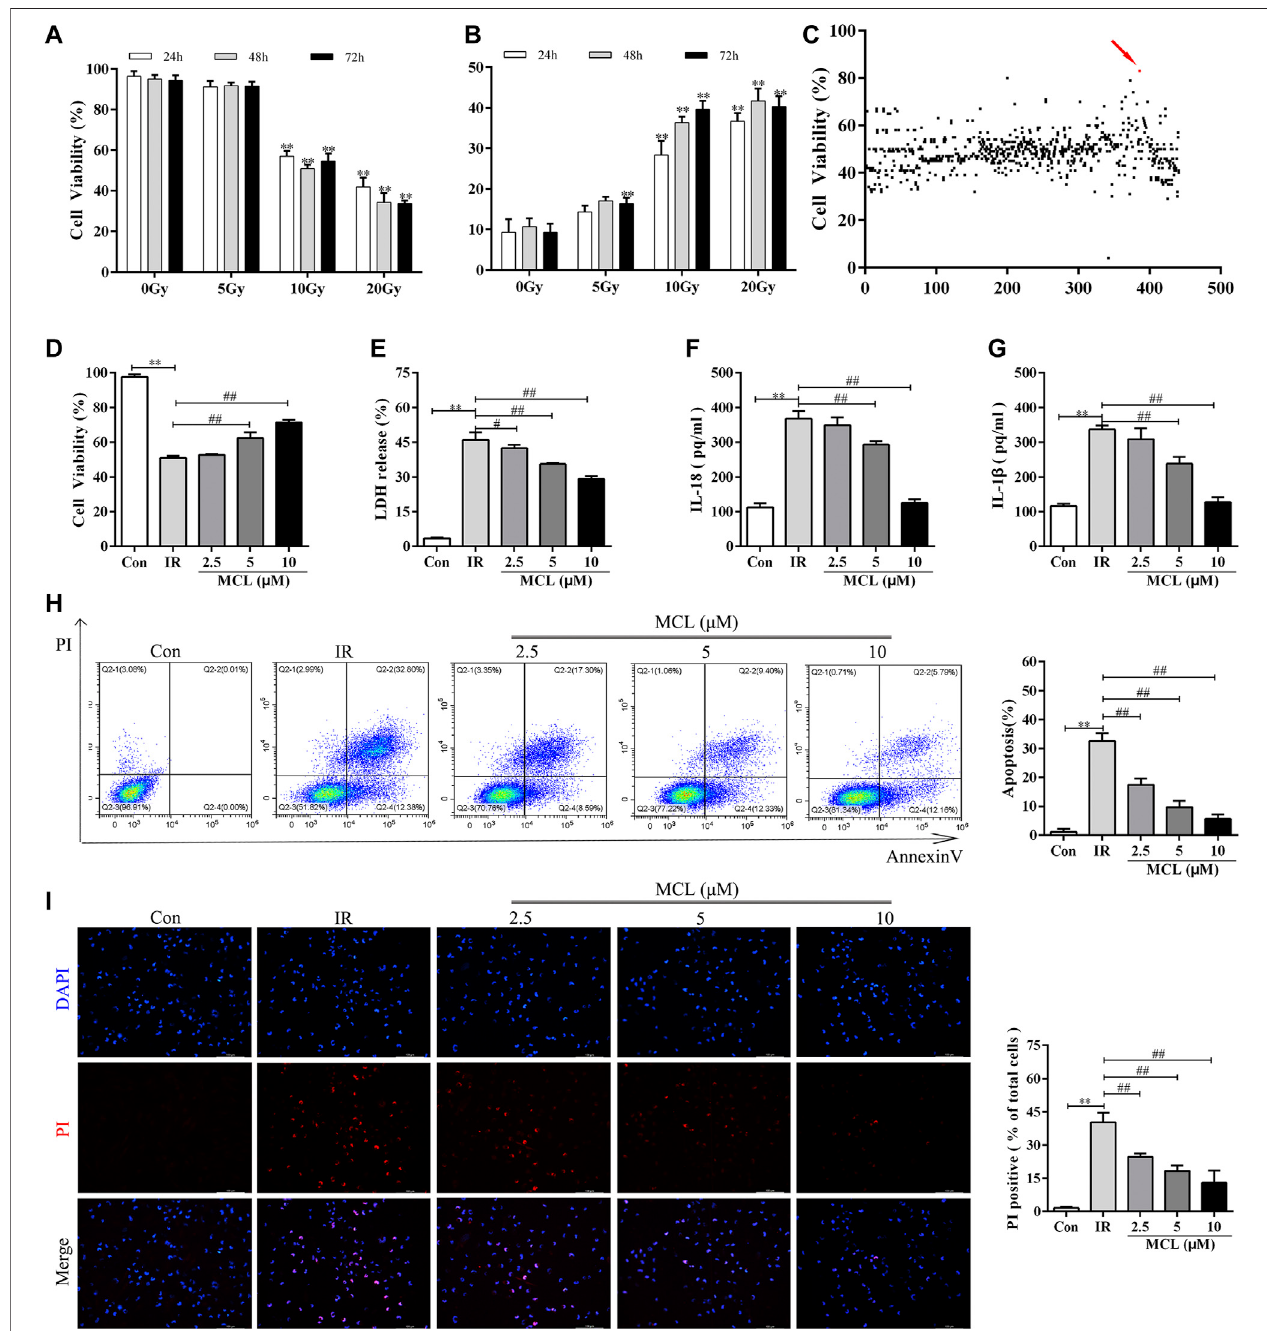
FIGURE1| MCLprotectsagainstradiationinHIECs (A) Cellviabilitywassigni fi cantlydecreasedinadose-dependentmannerfollowingtreatmentwithradiation(0, 5, 10, or 20 Gy) for 24, 48, or 72 h (B) LDH release increased in a time-and dose-dependent manner following radiation (0, 5, 10, or 20 Gy) (C) Cells were treated with 10 μ M ofthe drugcandidatelibrary for2 hand then exposed toradiation (10 Gy).Cell viabilityofHIECs exposedtothe drugcandidate library. Each point representsthe percentage ofcell viability ofthe compounds at aconcentration of10 μ M (D) MCL increased cell viabilityfollowing radiation (10 Gy)in adose-dependent (0, 2.5, 5, or 10 μ M) manner (E) MCL decreased LDH release following radiation (10 Gy) in a dose-dependent (0, 2.5, 5, or 10 μ M) manner (F) MCL decreased cell culture supernatant IL-18 release following radiation (10 Gy) in a dose-dependent (0, 2.5, 5, or 10 μ M) manner (G) MCL decreased cell culture supernatant IL-1 β release followingradiation (10 Gy) inadose-dependent (0, 2.5, 5, or10 μ M) manner (H) HIECs were pretreated with different concentrations(0, 2.5, 5, or10 μ M) ofMCL for 2 h and exposed to 10 Gy radiation. Representative fl ow cytometry scatter plots (I) HIECs were pretreated with different concentrations (0, 2.5, 5, or 10 μ M) of MCL for 2 h and exposed to 10 Gy radiation. Representative propidium iodide staining fl uorescence image. * p < 0.05, ** p < 0.01, *** p < 0.001, **** p < 0.0001, two-tailed Student ’ s t-test. HIEC, human intestinal epithelial cell; LDH, lactate dehydrogenase; MCL, micheliolide; IL, interleukin.